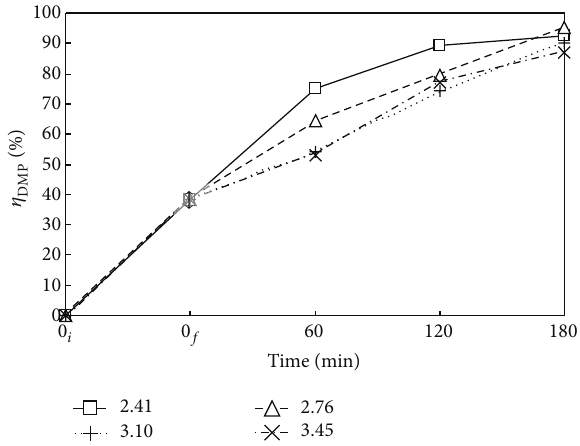
Figure 7: Time variation of 𝜂 DMP via WOP at various pressures. ◻ , △ , +, and × : 𝑃 𝑇 = 2.41, 2.76, 3.10, and 3.45 MPa. = 400 mL, 𝑇 = 483 K, and Nr = 500 rpm. Working gas after time = 0 𝑓 is O 2 . ↕ : Mean and Standard deviation (SD, 𝑛 − 1 method) at 𝑡 = 0 𝑓 : 38.2 ± 5.3.